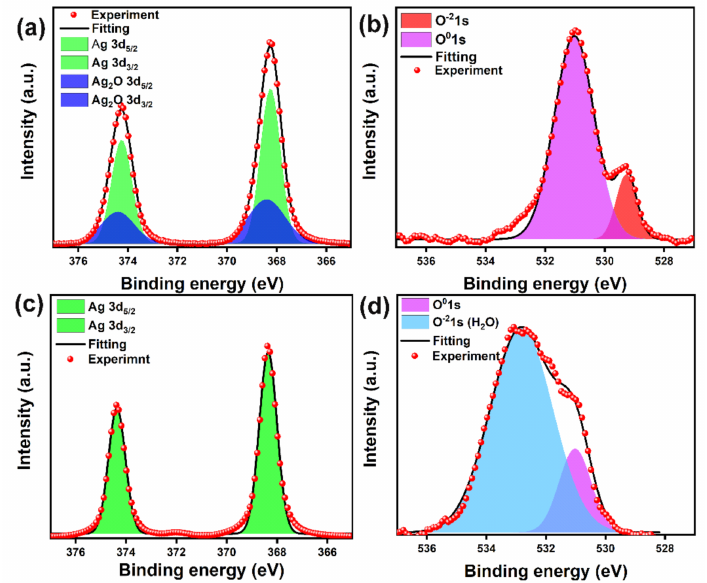
Figure 4. XPS analysis of Ag 2 O powder before and after a treatment in Pt-catalyzed formic acid vapor: ( a ) Ag3d spectra and ( b ) O1s spectra before the treatment, ( c ) Ag3d spectra and ( d ) O1s spectra after treatment.